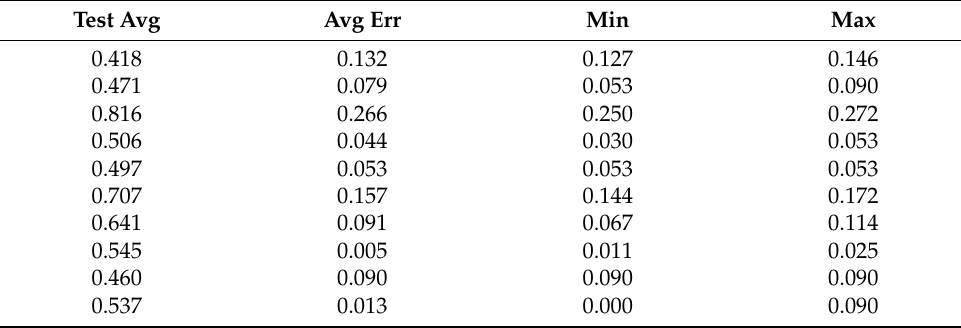
Table A223. Set 3, trials 41–50 data (all 0.5 PR